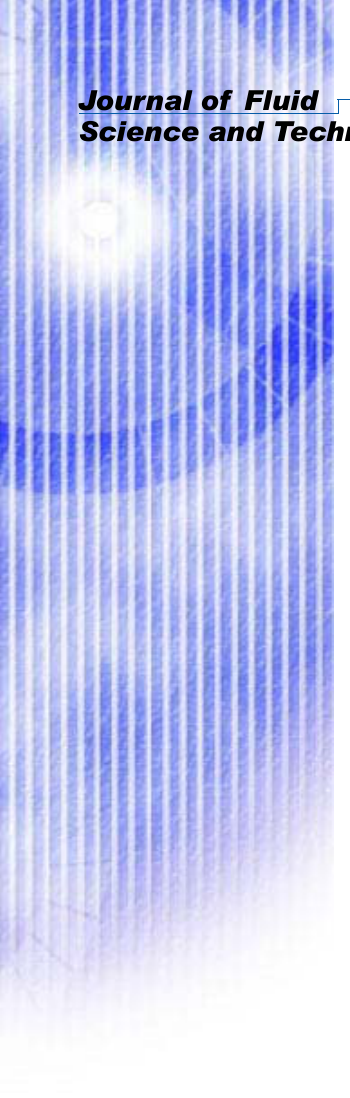
= 0.5L/min and Q = f a